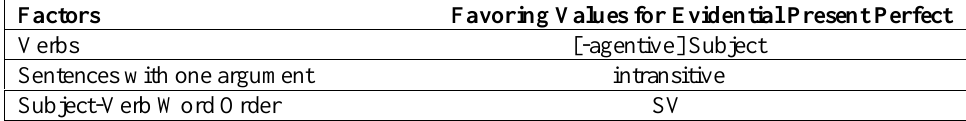
Table 7. Factors favoring the affectedness of the syntactic subject